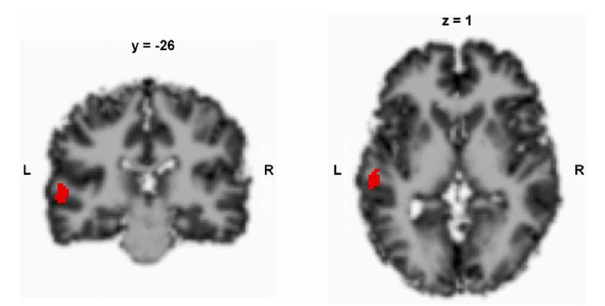
FIGURE 1 | Predefined region of interest in the left superior temporal gyrus. The local maximum peak values were retrieved from a previous study (Homan et al., 2012); according to SPM 8, x , y , z = − 58, − 26, 4; x , y , z coordinates in Talairach